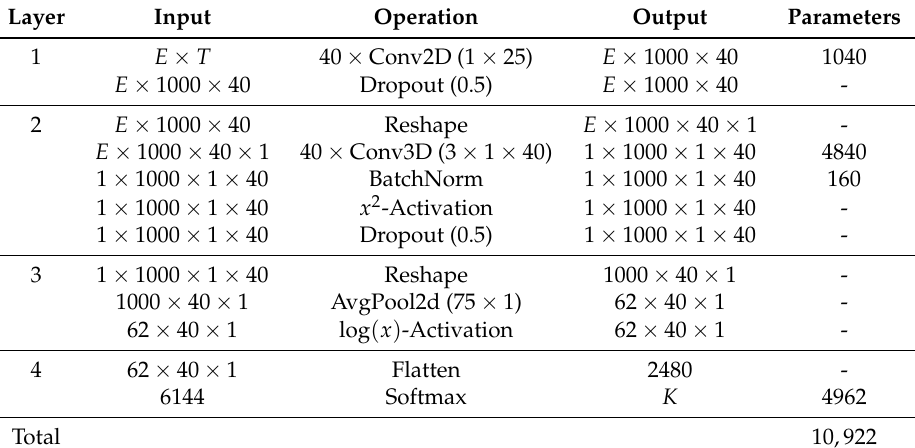
Table A3. Shallow CNN (sCNN) architecture by Schirrmeister et al. [18] (re-implemented in this work), where E is the number of channels, T is the number of timesteps and K is the number of classes. Input and Output sizes are shown for cropped training with E = 3 (electrodes C3, C4, and Cz) and T = 1024 for window size of 4 seconds; binary classification with two classes for K =